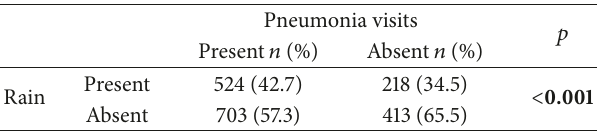
Table 5: Relationship between pneumonia visits and